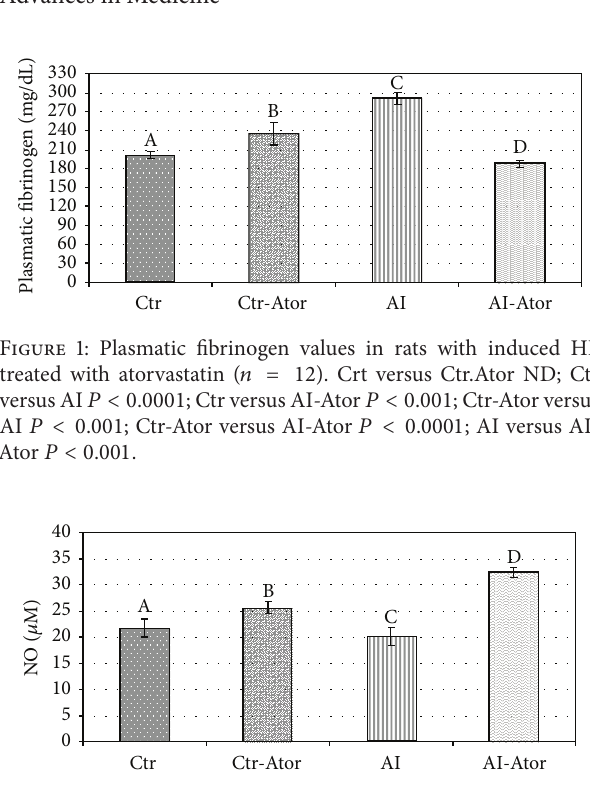
Figure 2: Behavior of plasmatic NO in rats with induced HF ( 𝑛 = 12 ). Crt versus Ctr.Ator ND; Ctr versus AI 𝑃 < 0.01 ; Ctr versus AI- Ator 𝑃 < 0.001 ; Ctr-Ator versus AI 𝑃 < 0.001 ; Ctr-Ator versus AI- Ator 𝑃 < 0.001 ; AI versus AI-Ator 𝑃 < 0.001 .